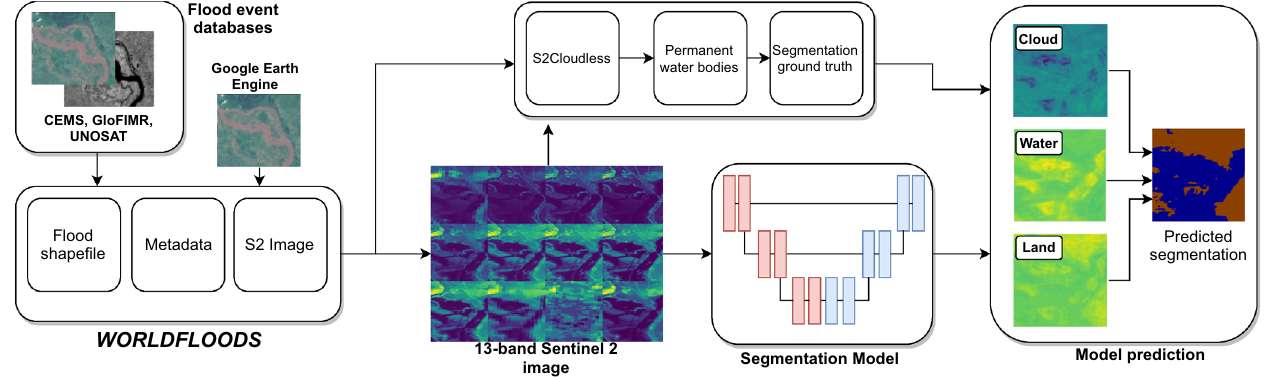
Figure 6. Overview of the model training pipeline used in this work. Note that WorldFloods provides images from S2, but reference flood extent maps may have been labelled from other sources, such as radar satellites.